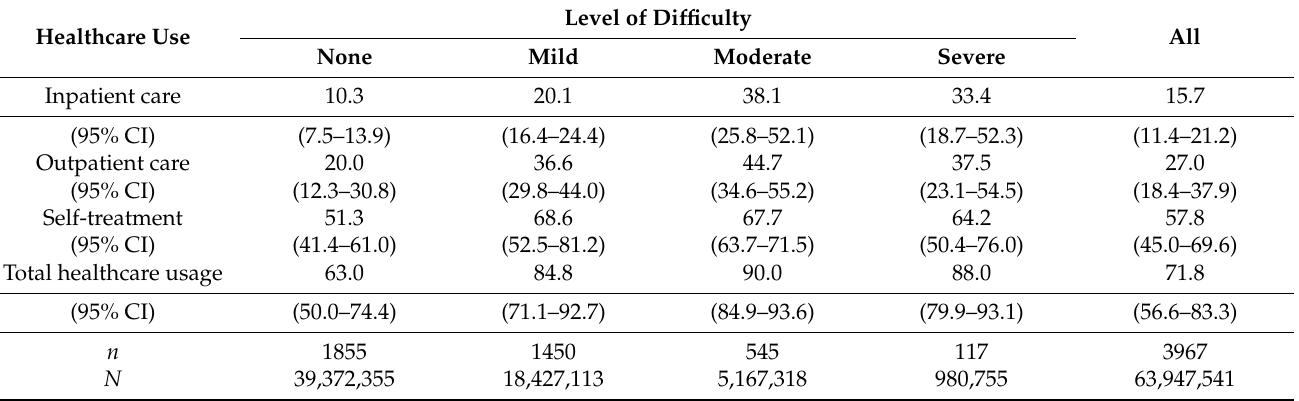
Table 2. Healthcare use